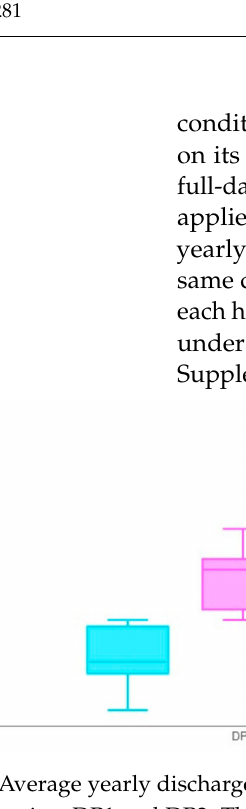
Figure 6. Average yearly discharge values (in m 3 /s) for the considered scenarios (i.e., dry, normal, and wet) for the two diversion points DP1 and DP2. The upper and lower fences represent the maximum and minimum discharge vales, the edges of the box represent the upper and lower quartiles, and the line inside the box is the